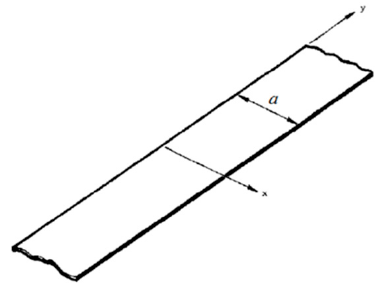
Figure 1. Logical scheme of similarities.